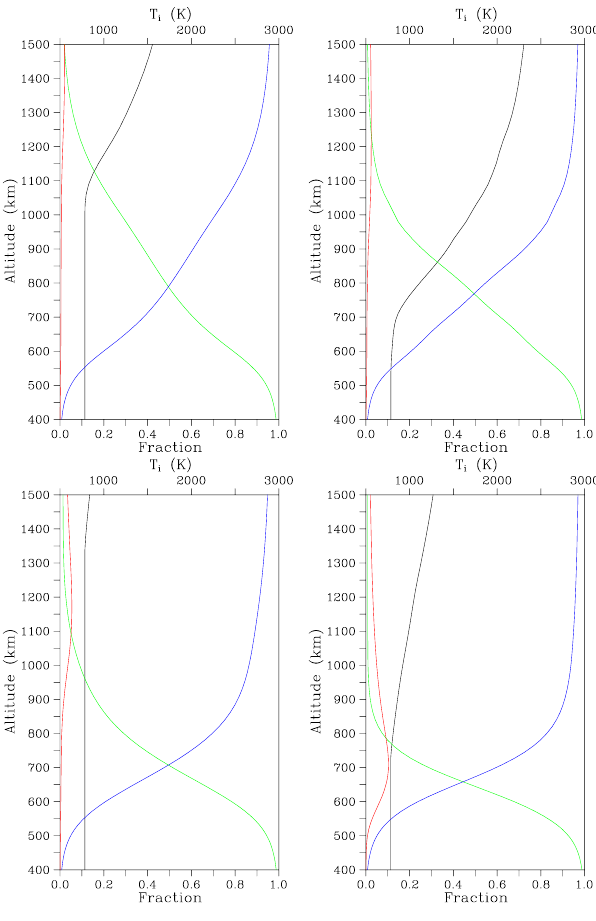
Fig. 7. SAMI2 simulation runs for Jicamarca June solstice, solar minimum conditions at 15 LT. Oxygen, hydrogen, and helium ion fractions are shown in green, blue, and red as in the previous fig- ure. The black curves show ion temperature. The left panels reflect simulations based on Fejer-Scherliess empirical vertical drifts. For the simulations depicted in the right panels, the vertical drifts were reduced by a factor of 4. The upper panels reflect simulations incor- porating HWM meridional neutral winds. Winds were set to zero for the simulations in the lower